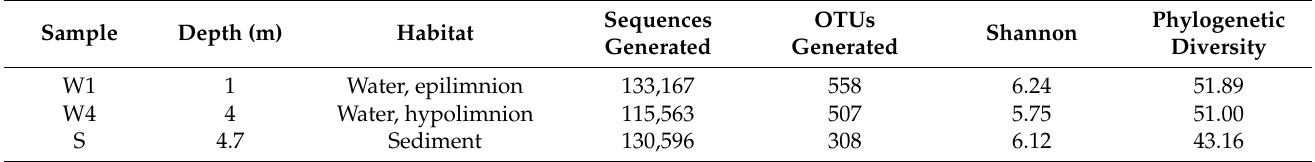
Table 2. Number of sequences and OTUs generated and diversity estimators from MiSeq Illumina sequencing analysis. Sample Depth